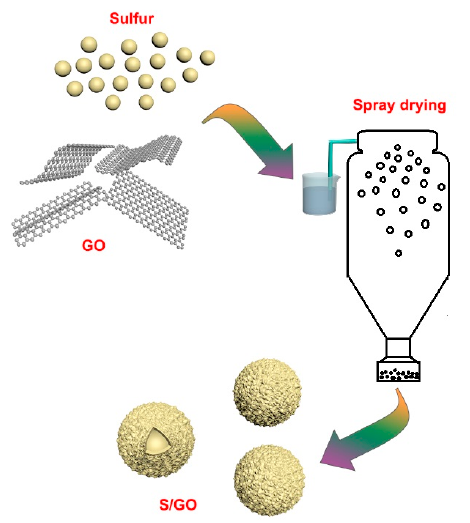
Figure 12. Schematic diagram of the fabrication of the S/GO composite powders.